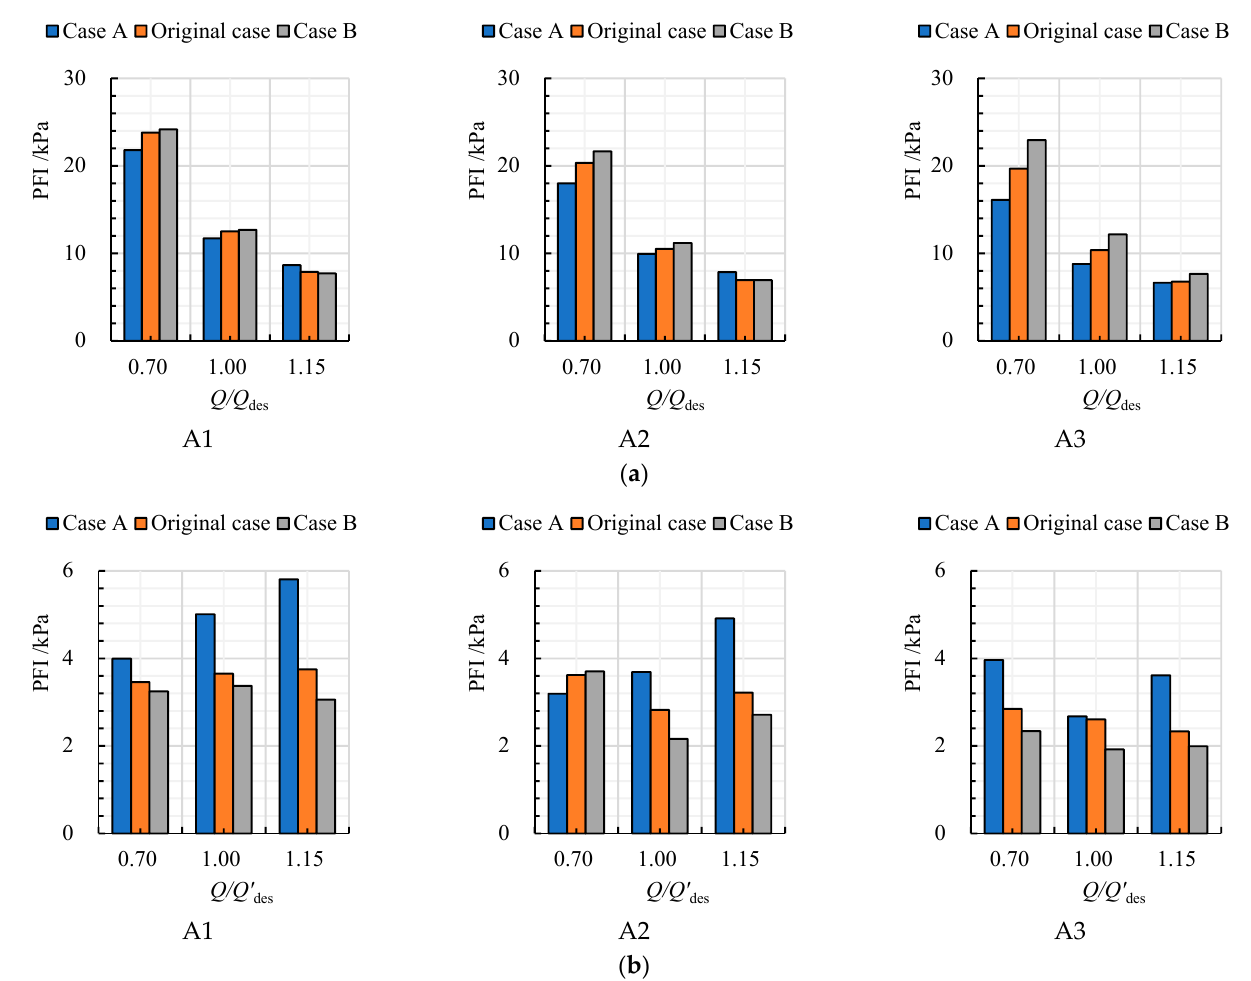
Figure 16. The distribution of PFI on A1, A2, A3 of three cases under ( a ) forward condition and ( b ) reverse condition.